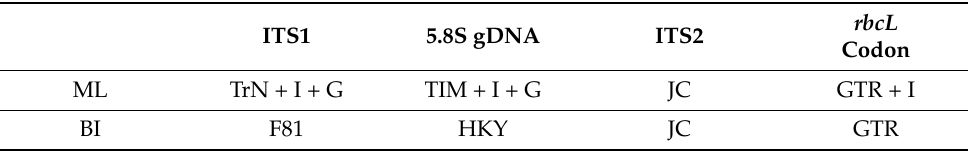
Table 3. Summary of partitions for the ITS matrix (1363 bp) and rbcL (698 bp); the evolutionary model selection and phylogenetic interference using PartitionFinder 2. ITS1 5.8S gDNA